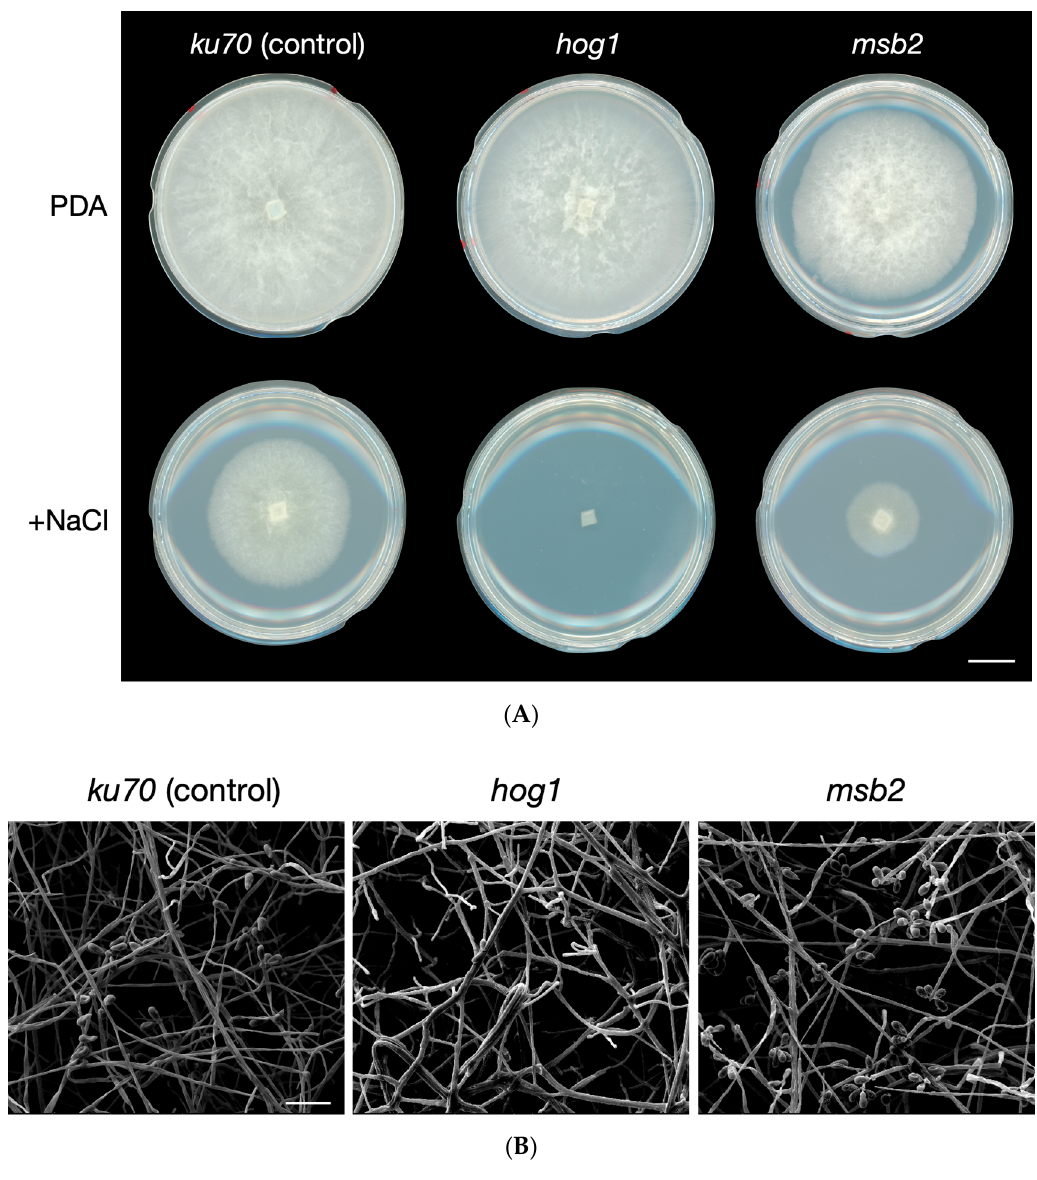
Figure 3. Defects of the hog1 and msb2 mutants in response to hyperosmotic stress. ( A ) Colonies of ku70 (control), hog1 , and msb2 mutants grown on PDA plates (5-cm diameter) for 4 days with or without 1% ( w / v ) NaCl (Scale bar, 1 cm). ( B ) SEM images of ku70 (control), hog1 , and msb2 mutants after growing on PDA plates (5-cm diameter) for 4 days (Scale bar, 50 µm).